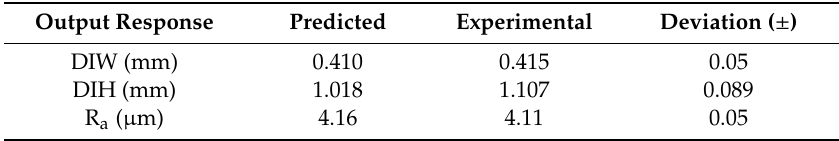
Table 7. Statistically predicted and confirmatory experimental values for output